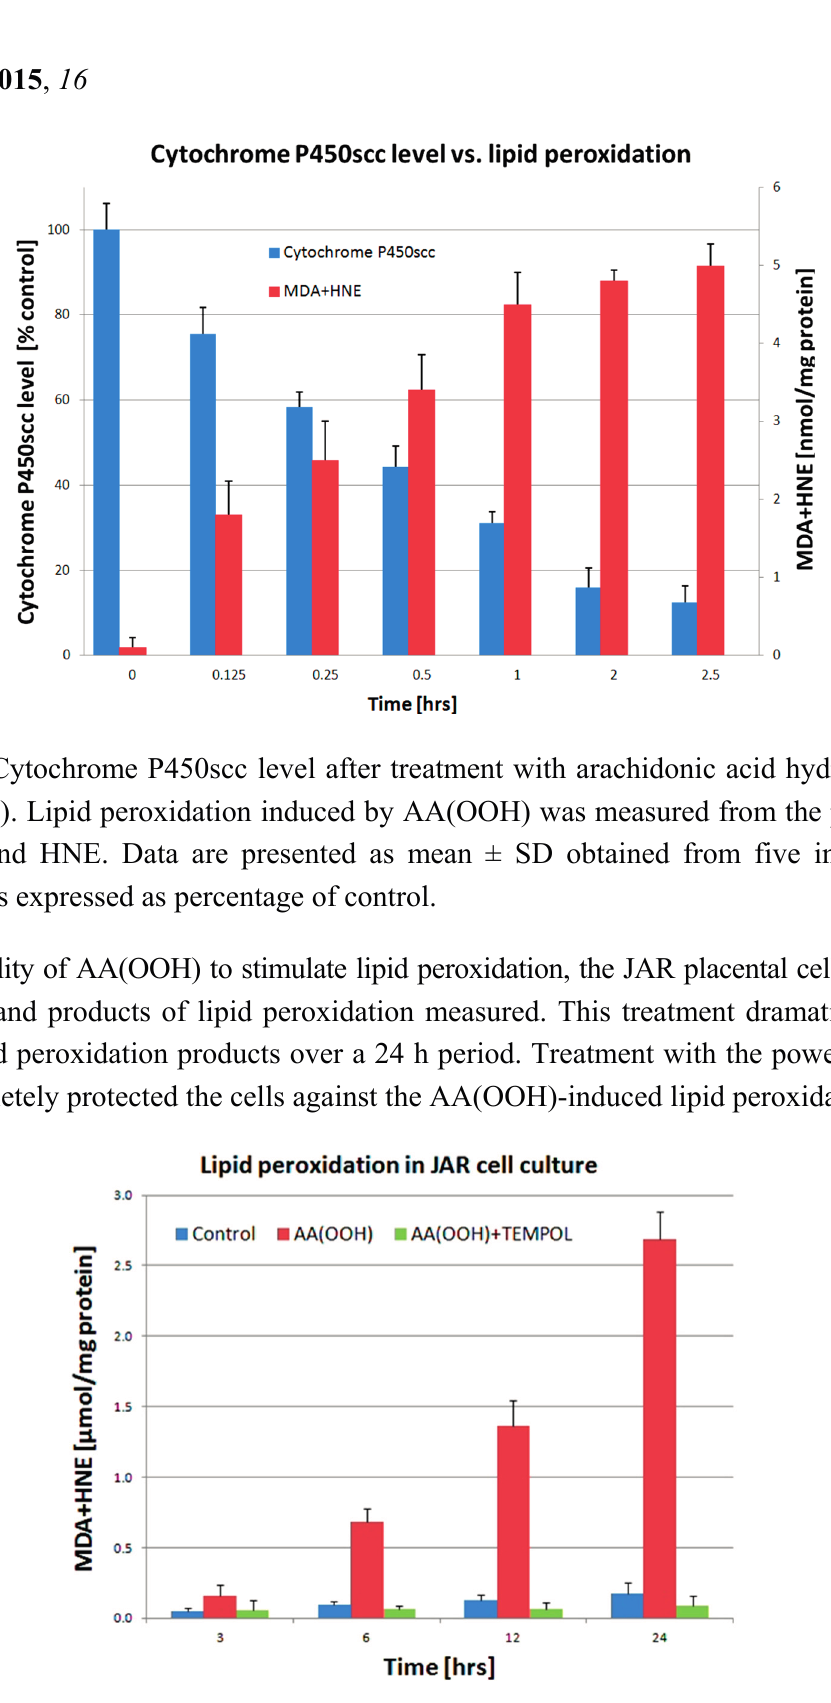
Figure 5. Lipid peroxidation in JAR cell culture. Control cells, cells treated with 100 µM Arachidonic Acid Hydroperoxide AA(OOH), cells treated with 100 µM AA(OOH) and 50 µM TEMPOL (AA(OOH) + TEMPOL). Products of lipid peroxidation (MDA plus HNE) were significantly elevated in cells treated with AA(OOH) only. Data presented as mean ± SD obtained from five independent